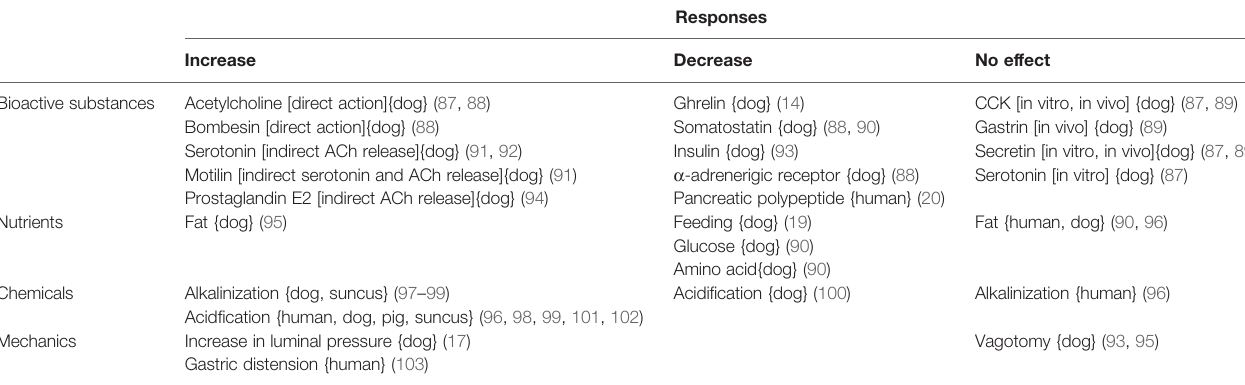
TABLE 2 | Regulatory stimulants for endogenous motilin release in